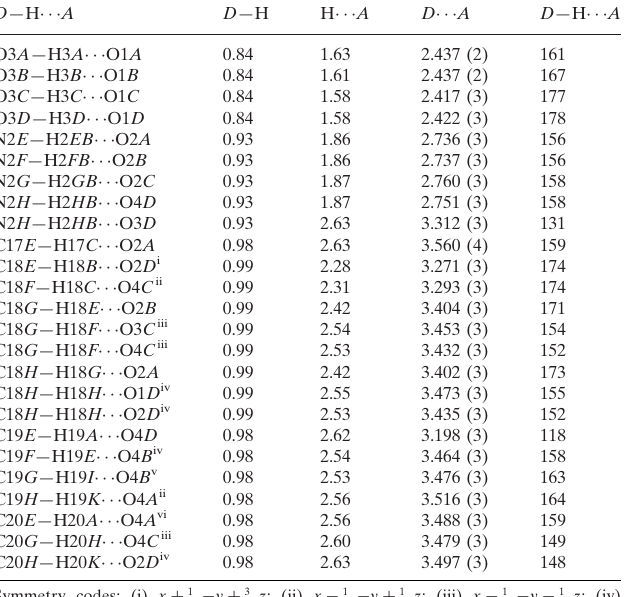
Data collection Oxford Diffraction Xcalibur diffractometer with a Ruby (Gemini Cu) detector Absorption correction: multi-scan ( CrysAlis RED ; Oxford Diffraction, 2007)